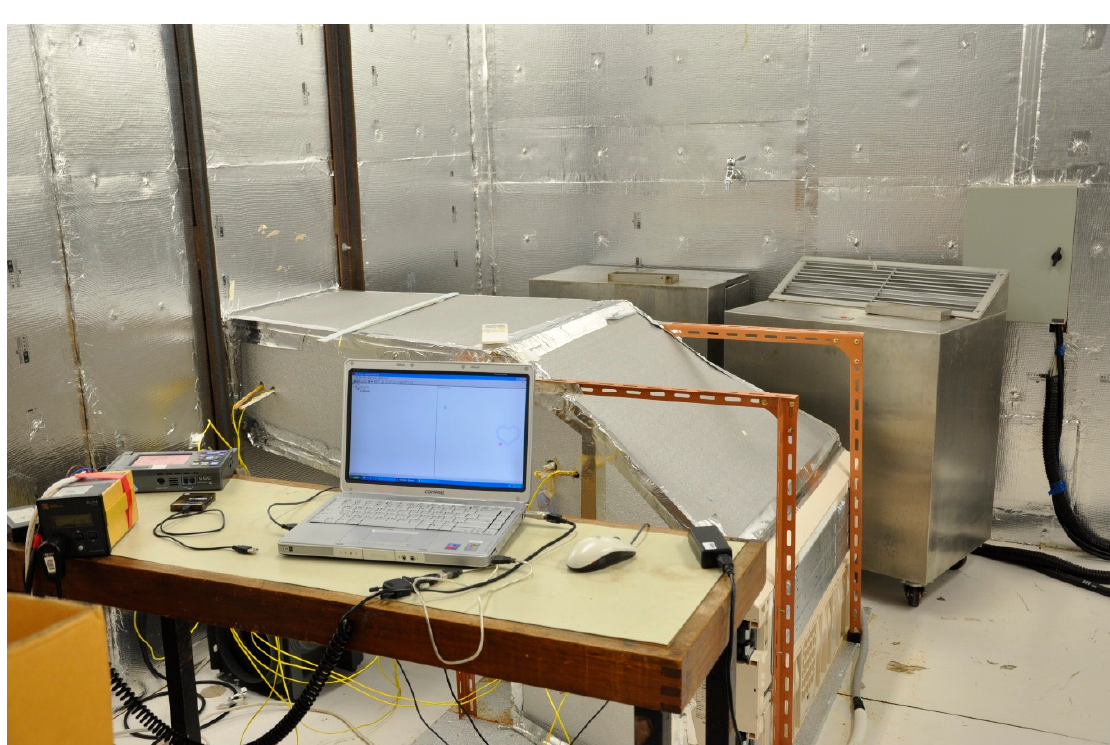
Figure 6. Photo of experimental environment.